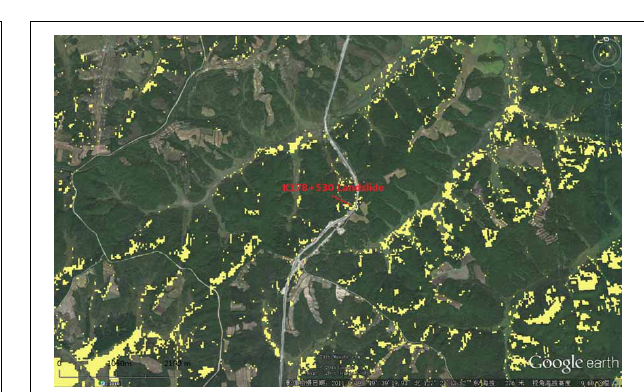
FIGURE 7 | Permafrost distribution map in K176 + 500 - K180 + 000 section of Bei’an-Heihe Highway.